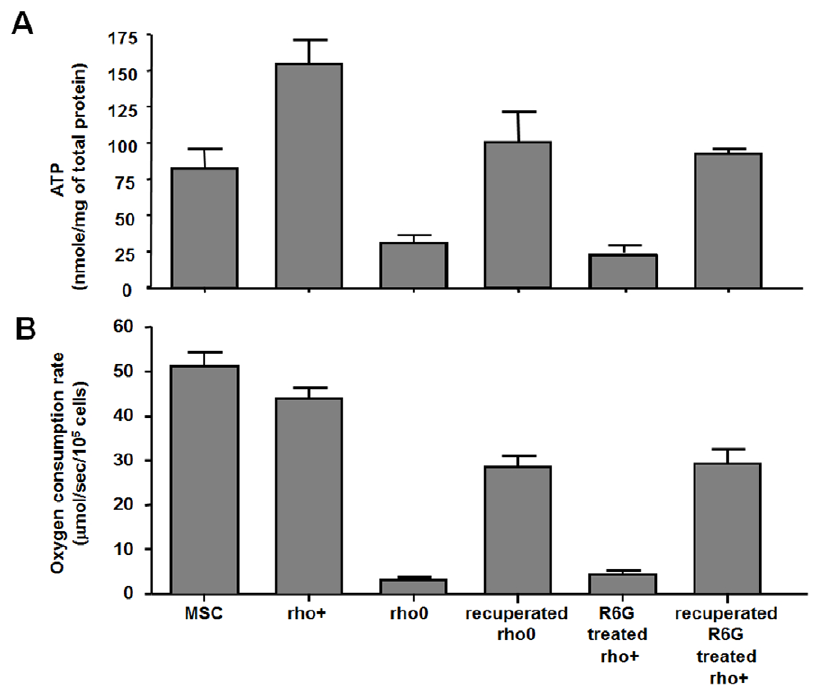
Figure 4. Characteristics of the recuperated TM143B cells. (A) 143B r 0 cells and R6G-treated 143B r + cells showed very low intracellular ATP content. Restored cells (TM143B) from both conditions contained much higher ATP content. (B) Oxygen consumption rates show a pattern similar to that of intracellular ATP content. Restored cells from both conditions had much higher oxygen consumption rates.